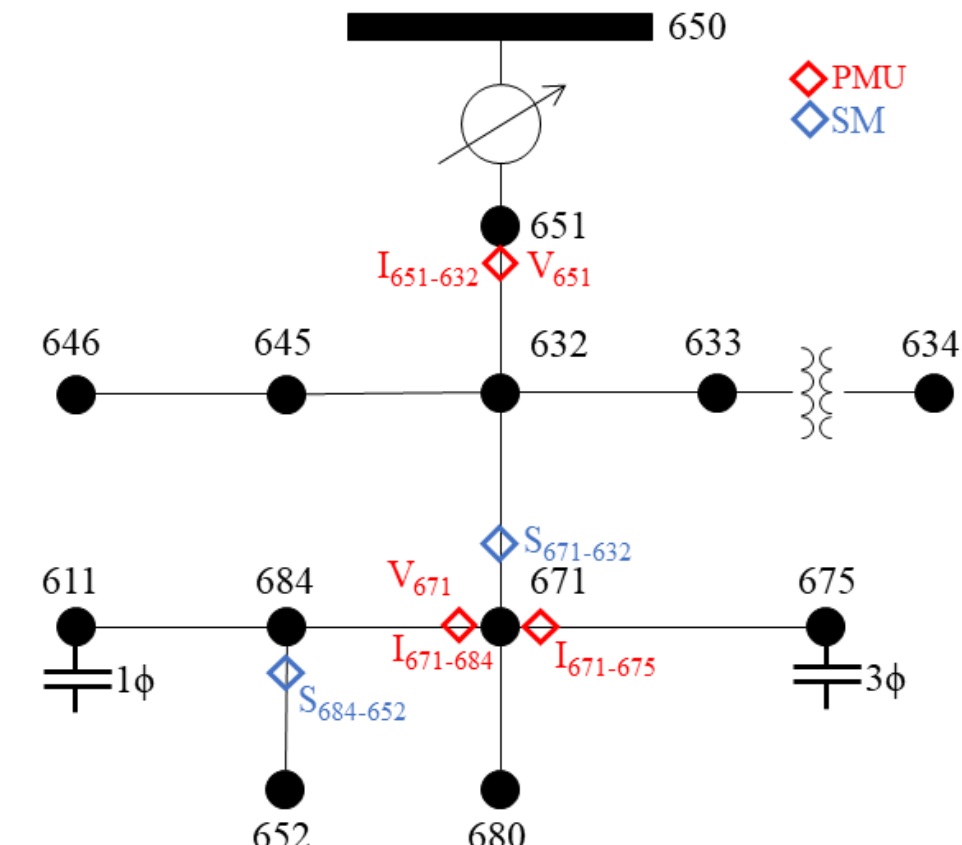
Figure 4. Test system for parameter detection and identification test.